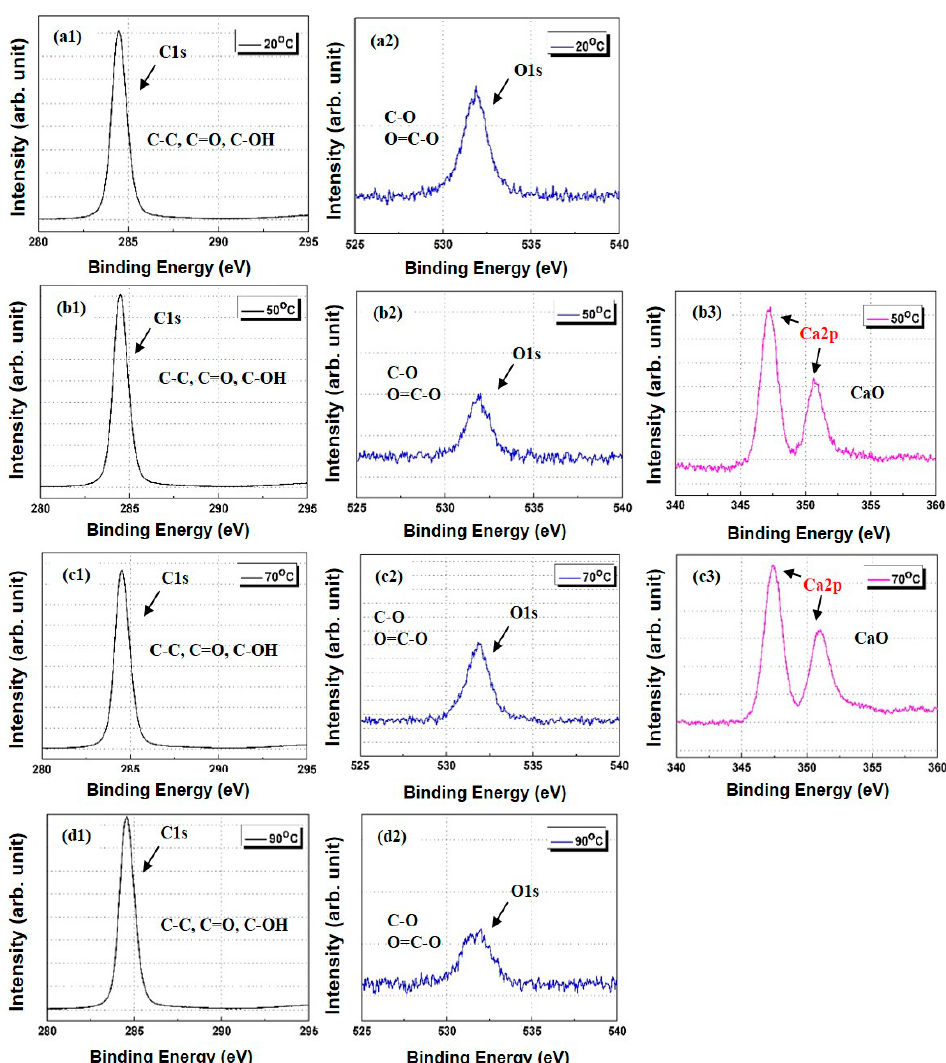
Figure 9. XPS spectra of polypropylene/lubricant (Ca) composites aged at different temperature conditions under 100% humidity: ( a ) C1s and O1s spectra at aging temperature of 20 °C; ( b ) C1s, O1s, and Ca2p spectra at aging temperature of 50 °C; ( c ) C1s, O1s, and Ca 2p spectra at aging temperature of 70 °C; and ( d ) C1s and O1s spectra at aging temperature of 90 °C.